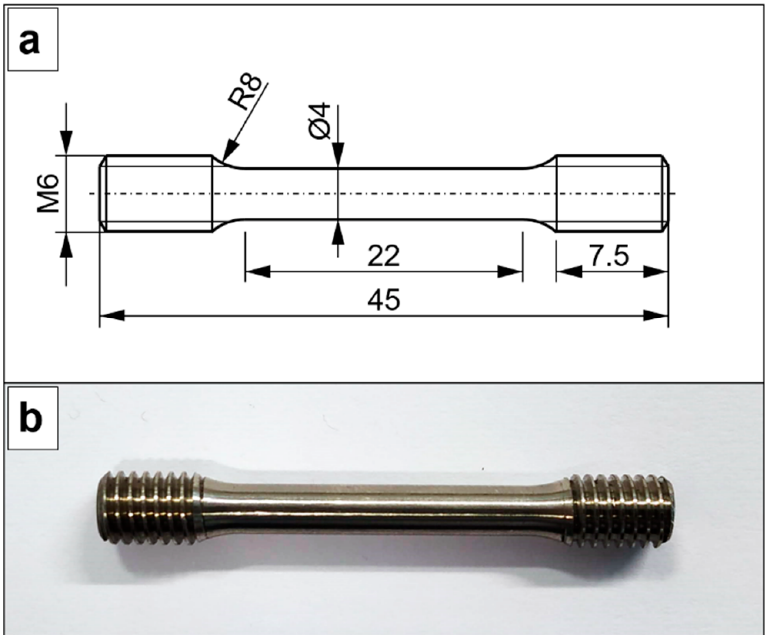
Figure 5. ( a ) Geometrical dimensions of the specimens for tensile test. ( b ) Specimen for the tensile test. All dimensions are shown in